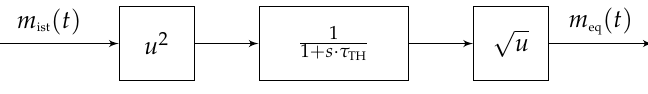
Figure 7. Example implementation of the torque